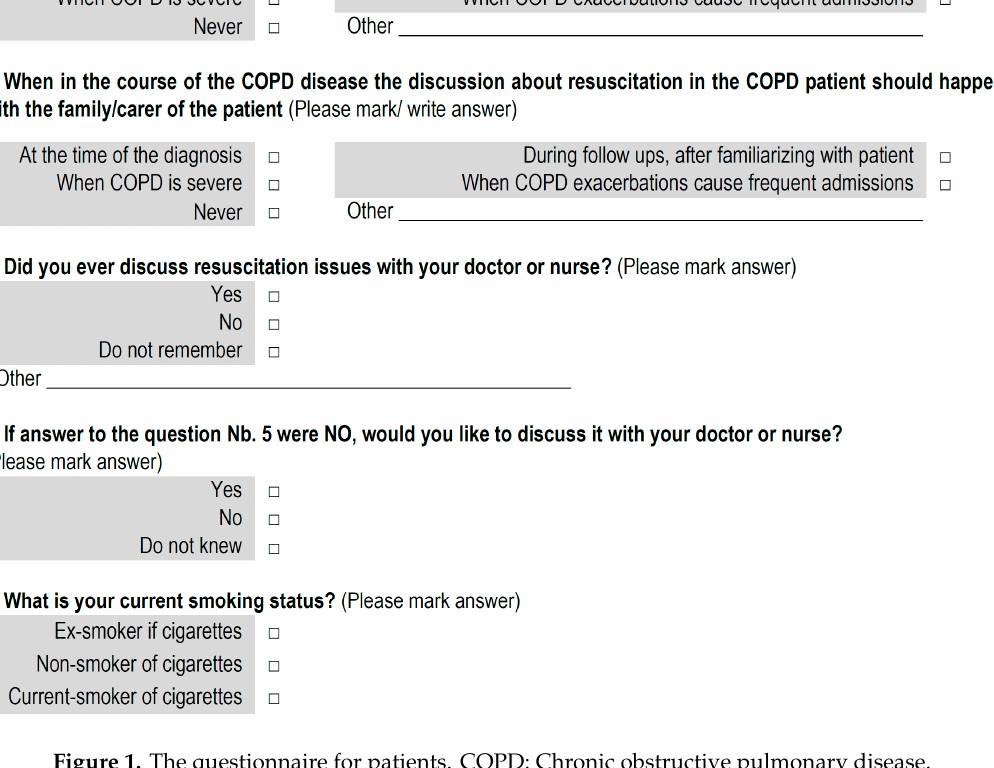
Figure 1. The questionnaire for patients. COPD: Chronic obstructive pulmonary disease.